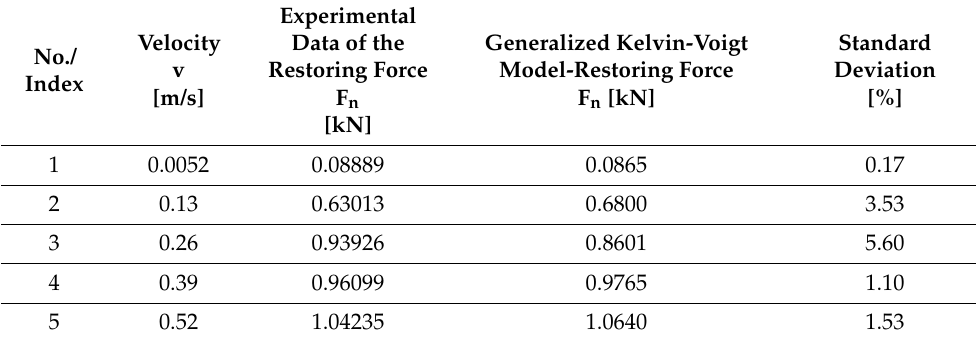
Table 3. The correlation between the experimental values and the extended Kelvin–Voigt model.